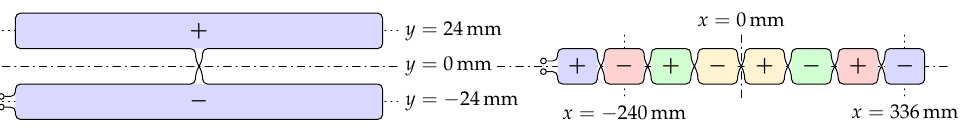
Figure 4. Sensor coil schematics—the signs represent the orientation of the conductor loops, the colors indicate the distance to the symmetry axis ( left ) sensor coil 2 ( right ) sensor coil